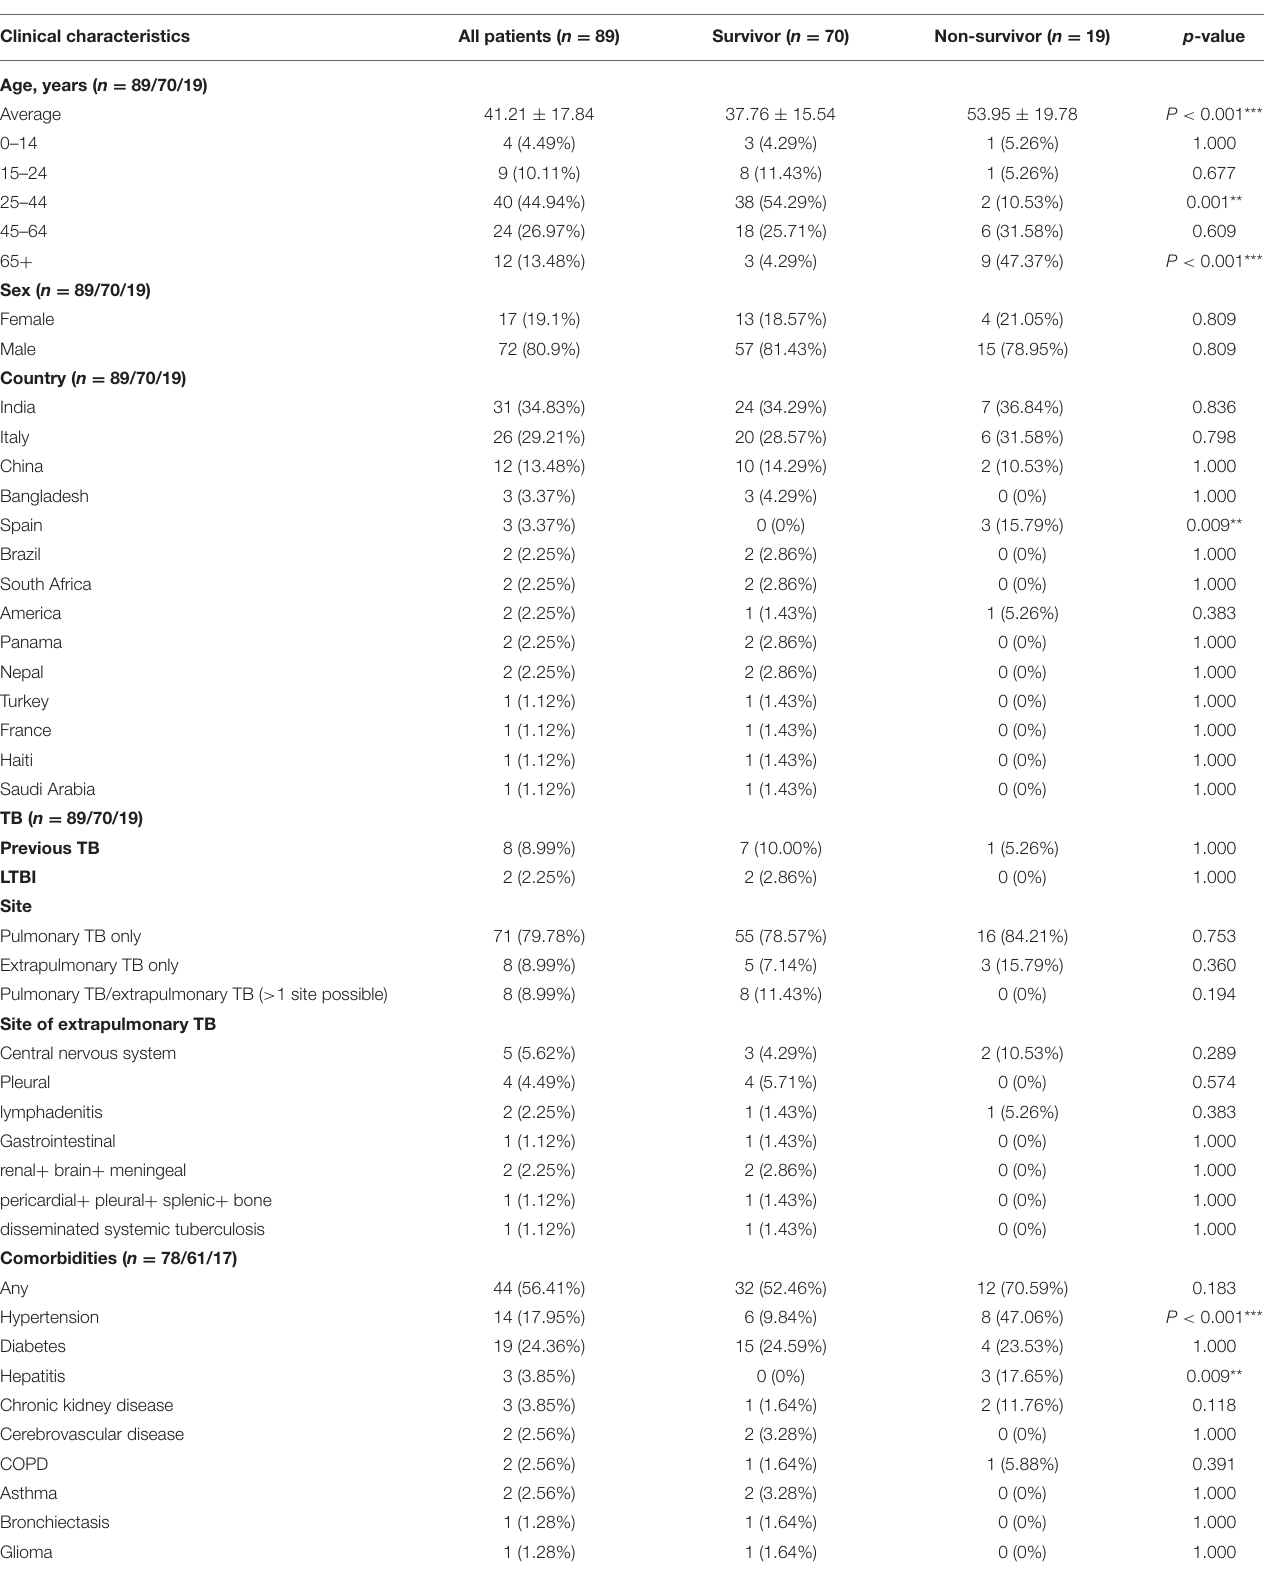
TABLE 2 | Clinical characteristics of 89 patients with COVID-19 disease and tuberculosis. Clinical